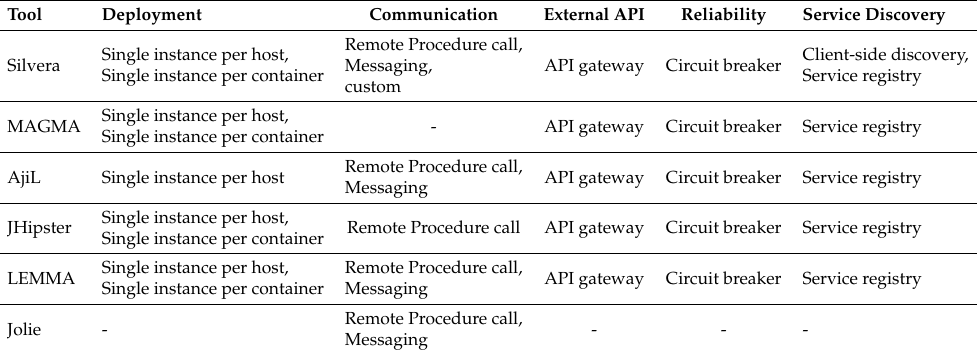
Table 4. Comparison of microservice design patterns implemented in Silvera with other